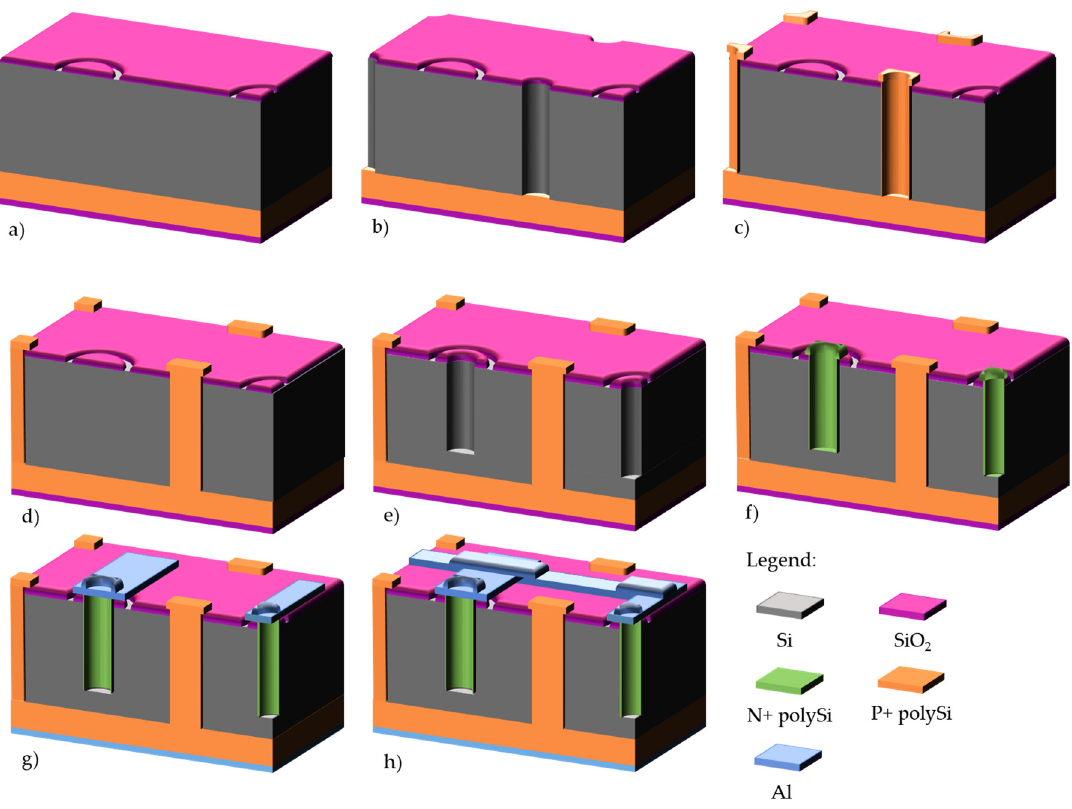
Figure 17. IMB-CNM 3D-SiSi technology on Si-Si p-type wafers: ( a ) field oxidation and p-stop definition; ( b ) p + window patterning and DRIE of p + electrodes; ( c ) polysilicon deposition and p + doping; ( d ) sealing of p + electrodes with undoped polysilicon; ( e ) pattern and etching of n + window, and DRIE of n + electrodes; ( f ) polysilicon deposition and n + doping; ( g ) front and backside metal deposition and patterning on the front side; ( h ) Deposition and patterning of temporary metal for electrical characterization of pixel detectors. Fabrication of Si-Si wafers is done externally and therefore not included in the process.